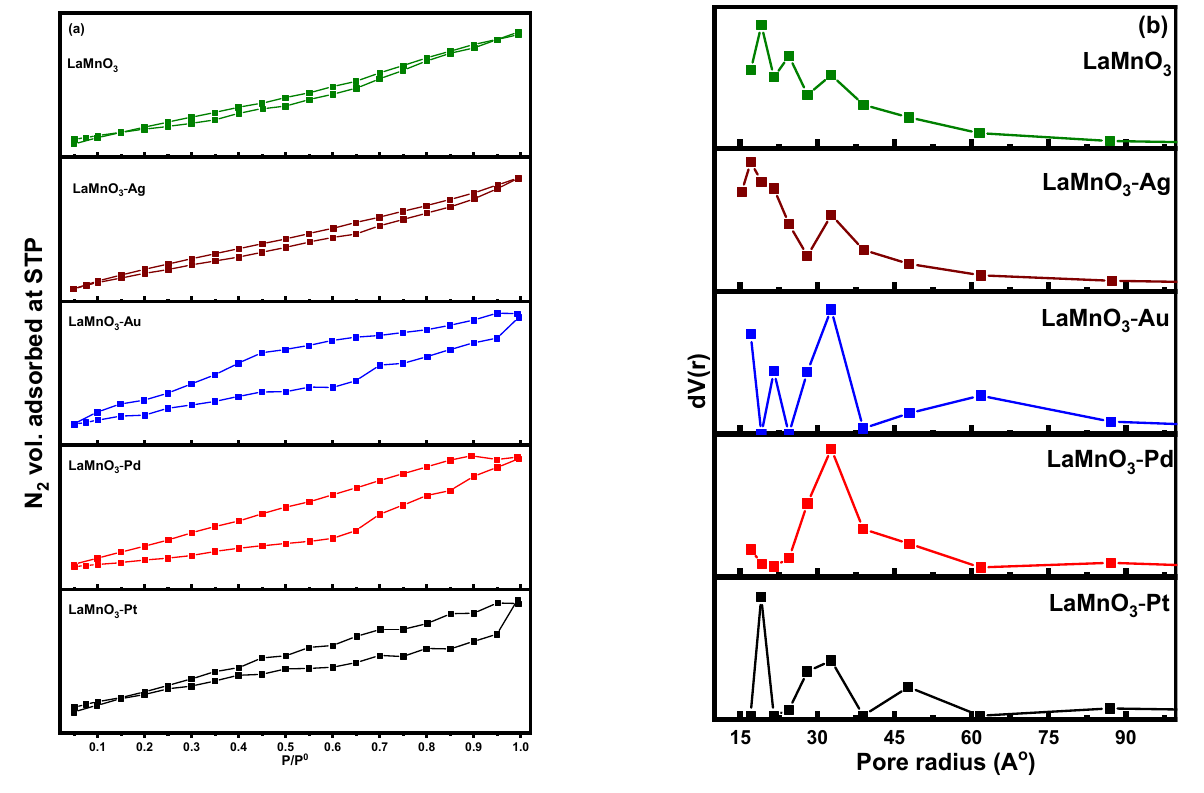
Figure 5. ( a ) N adsorption-desorption isotherms and ( b ) pore size distribution patterns of the sam- Figure 5. ( a ) N 2 adsorption-desorption isotherms and ( b ) pore size distribution patterns of 2 ples. the samples.